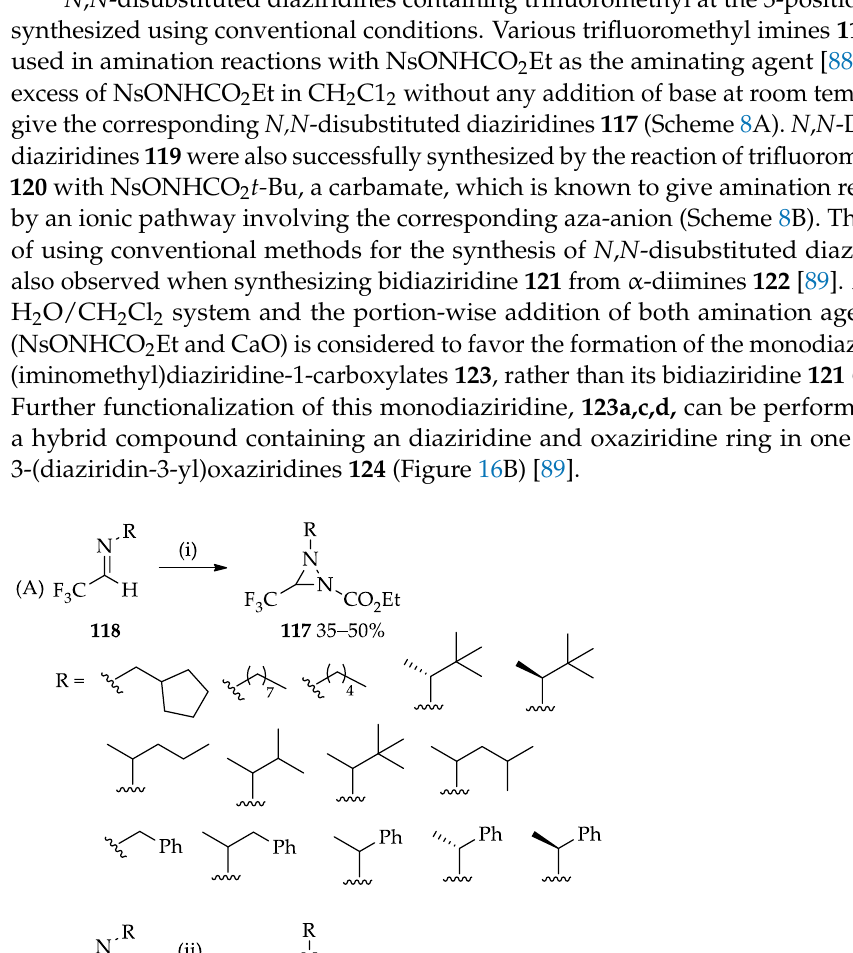
Figure 16. Synthesis of monodiaziridine 123 and bidiaziridine 121 from α-diimines 122 ( A ) and fur- ther substitution for 123 ( B ). Conditions: (i) NsONHCO 2 Et, H 2 O/CH 2 Cl 2 , CaO, rt; (ii) m -CPBA, CH 2 Cl 2 , 0 °C. In line with the synthesis of the hybrid compound, a diastereoselective method for the synthesis of diaziridines with N - and/or C - cyclopropyl substituents ( 125 and/or 126 ) was developed [90] using the conventional methods. A one-pot, three-component con- densation of cyclopropyl-containing carbonyl compounds 127 , primary aliphatic amines, including cyclo propylamine 128 , and N -chloroalkylamines 129 was conducted in the or- ganic solvents. This typical reaction was carried out under mild conditions and in the presence of bases (Scheme 9), resulting in the predominance of diaziridine product 125 and/or 126 , with the major diastereomer being the racemic mixture of two meso-forms, and the racemic mixtures of two enantiomers for the minor diastereomer. The use of K 2 CO 3 as a base, and an aprotic solvent (CHCl 3 ) obtained from equimolar amounts of aldehyde, cyclopropylamine, and pre-synthesized N- chloroalkylamines can provide access to compounds with cyclopropyl substituents on the nitrogen atom of the diaziridine ring. As for the enantio- and diastereoselective synthesis of diaziridines 130 via aziridination of N -tosyl aldimines 131 while applying modified hydroxylamine 132